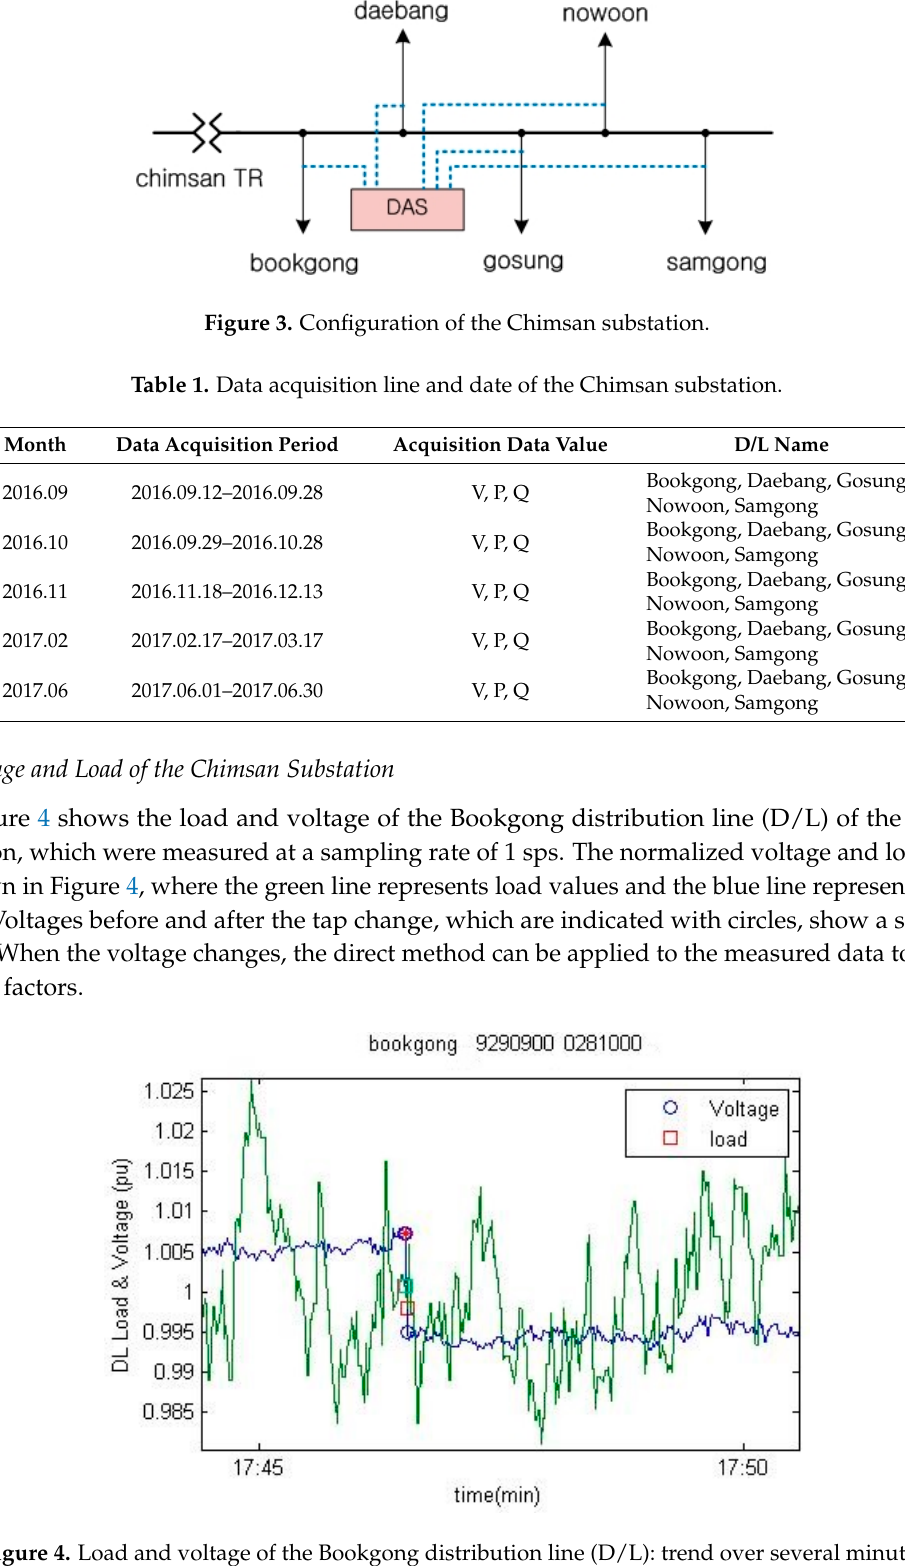
Figure 4. Load and voltage of the Bookgong distribution line (D/L): trend over several minutes.